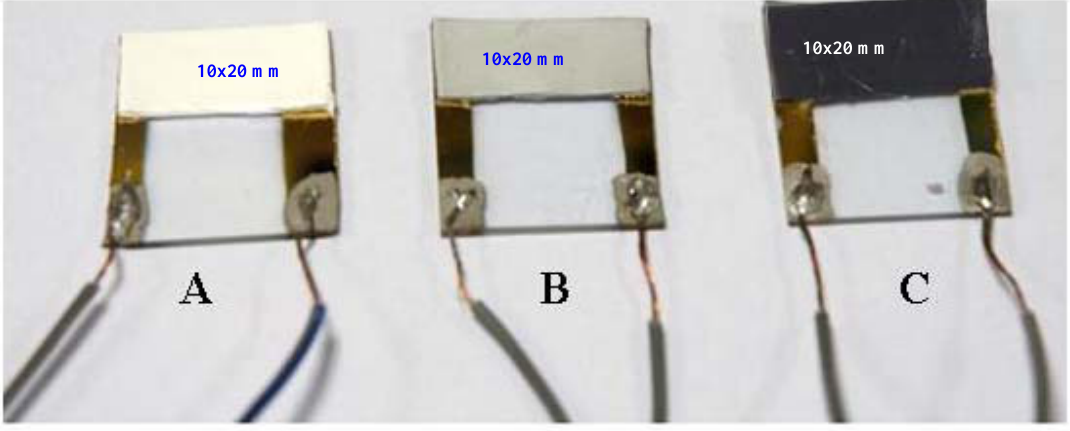
Figure 3. Sensing device fabricated with (A) neat Nylon-6 nanofibers on an area of 10